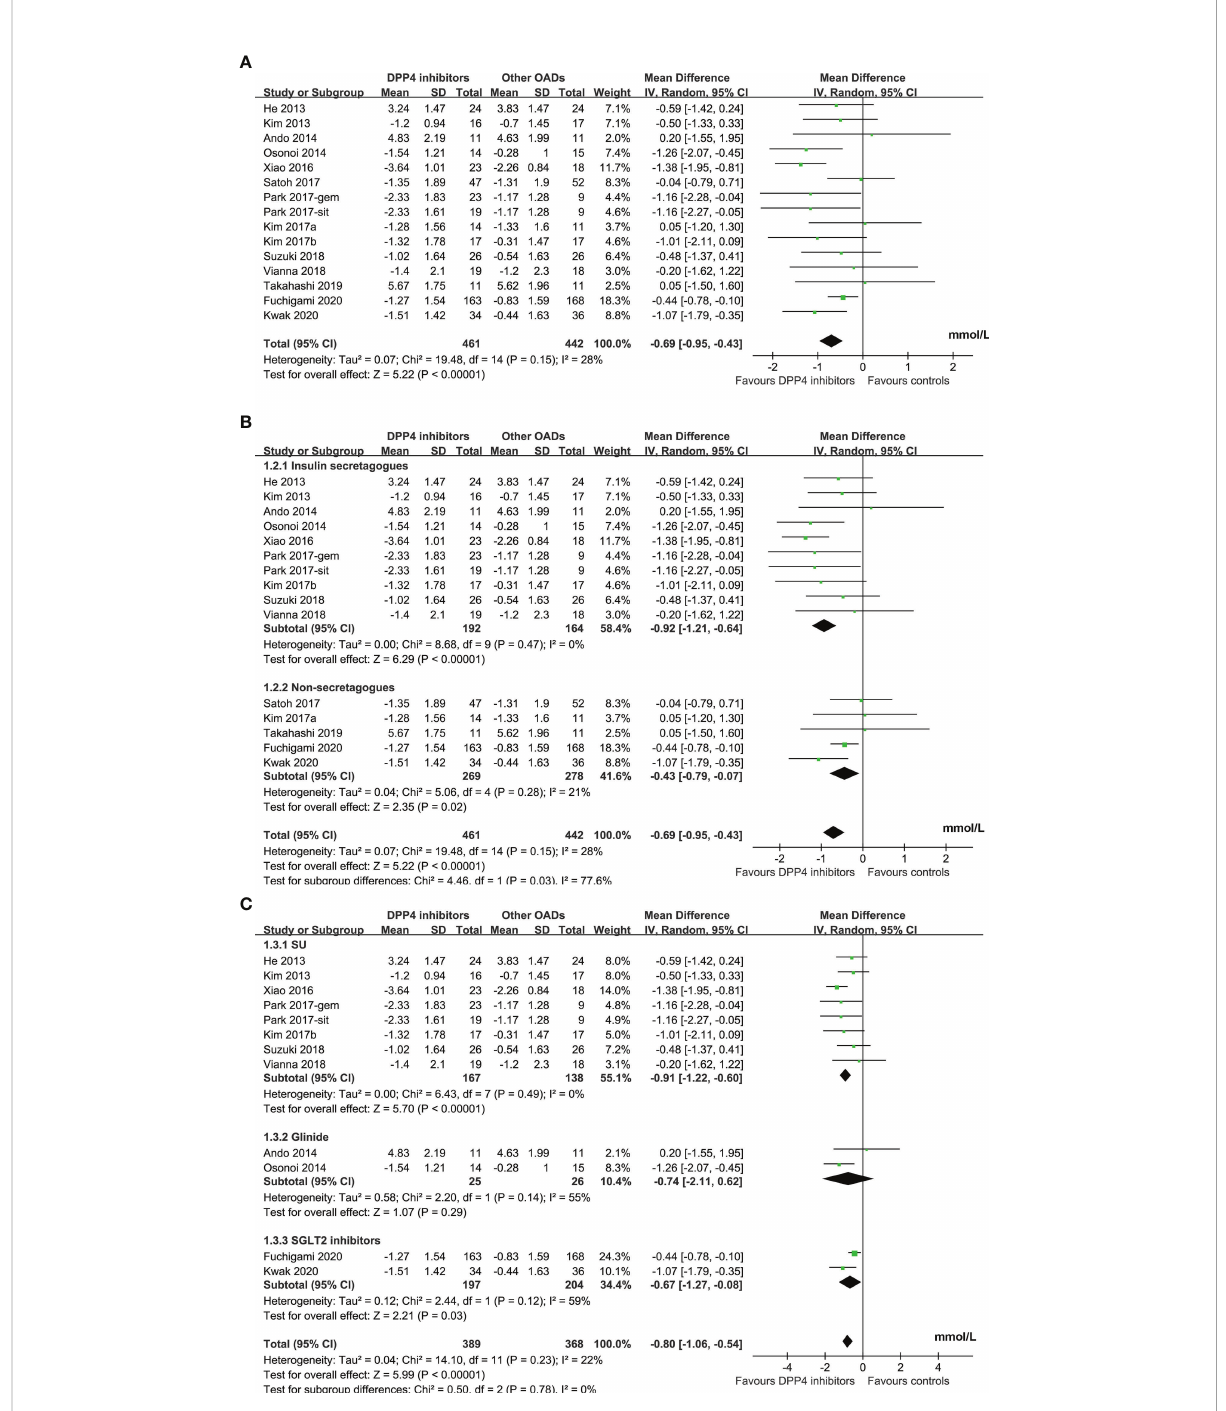
FIGURE 2 Forest plots for the meta-analysis comparing the in fl uence of DPP4 inhibitors on MAGE with other OADs in T2DM patients with no concurrent insulin therapy; (A) , forest plots for the overall meta-analysis; B) , forest plots for the subgroup analysis according to the control OADs; and (C) , forest plots for the subgroup analysis according to the individual OAD class of